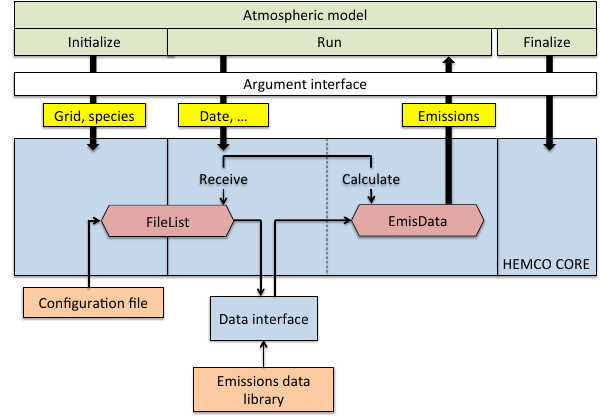
Figure 1. Overview of the HEMCO core module, which acts as a coupler between the atmospheric model and emission files orga- nized in a data library. All emission calculations are based on the information provided in the HEMCO configuration file, which is read and stored in the internal file list (“FileList”) during initializa- tion ( Initialize ). By modifying the content of the data library and configuration file, users can readily add new emission data and change emission calculation settings. HEMCO calculates emissions for a given species, date, and grid in two steps: first, all emission data to be updated are identified and selected from FileList and re- ceived through the data interface (“Receive”). The returned data be- come stored in the “EmisData” list, from which the final emission array is assembled in the second step of RUN (“Calculate”). This ar- ray is then returned to the atmospheric model. Routine FINALIZE , called at the end of a model run, cleanly removes all internal